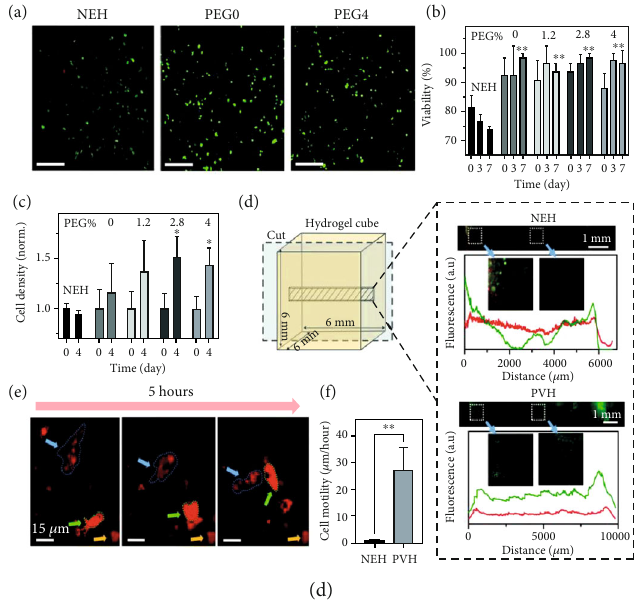
Figure 1: Encapsulation techniques for improving stem cell viability. (a) Microgel encapsulating stem cells can self-assemble into 3D microporous sca ff old and (b) maintain high cell viability and chondrogenic di ff erentiation potential. (c) Triggered micropore-forming bioprinting strategy improved cell viability compared to bulk hydrogel and (d) cell migration in micropore hydrogels. Reproduced with permission [13,